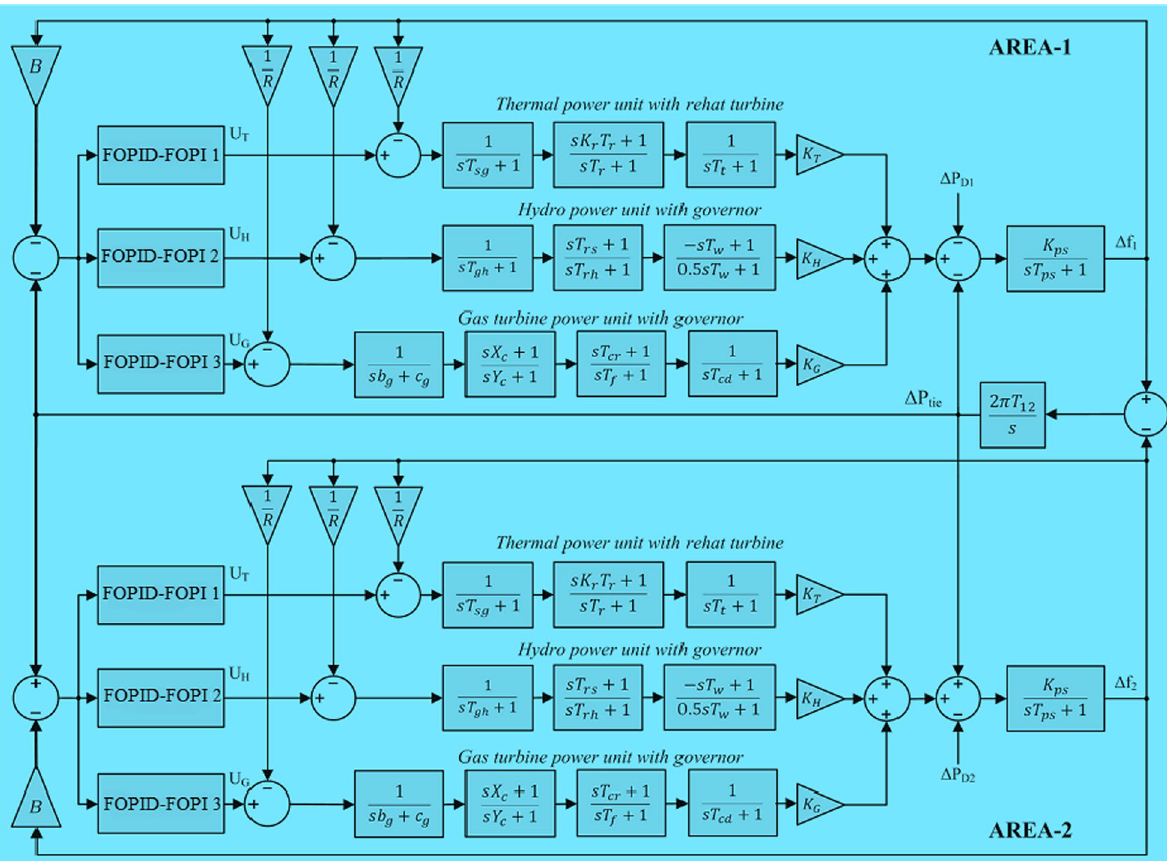
Fig. 2 TF model of two-area multi-source system (Test-system